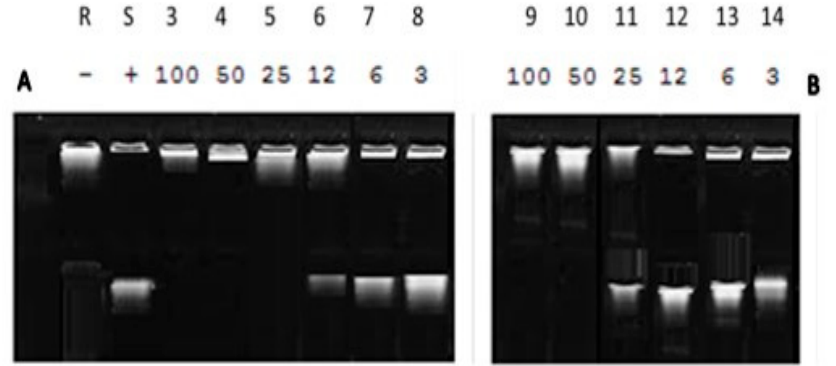
Figure 6. Supercoiling reactions at different concentrations of ( A ) ciprofloxacin (Standard) and ( B ) cyclic diphenylphosphonate 2a . Lanes 3–14: different concentrations of compound 2a and ciprofloxacin, respectively (3–14), Lane R: relaxed pNO1, Lane S: supercoiled pNO1 of E. coli DNA gyrase.